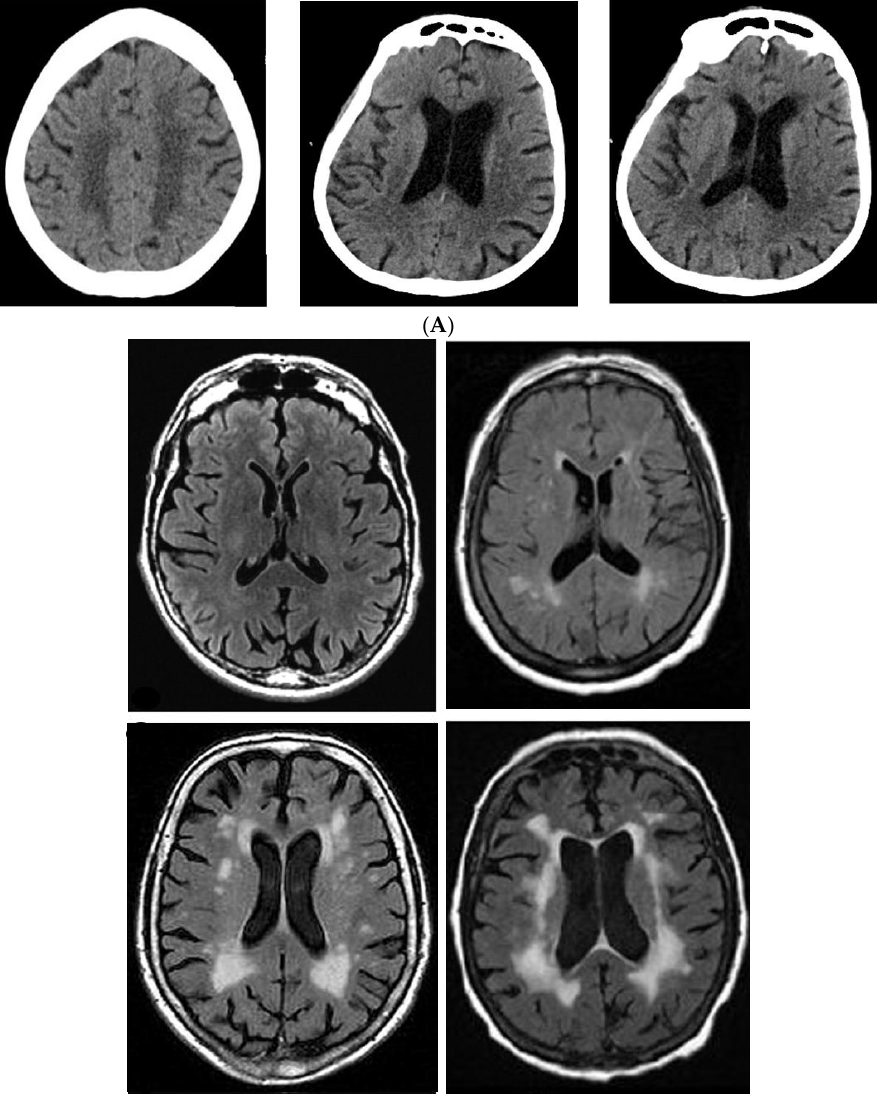
Figure 1. ( A ) Non-contrast brain computed tomography with leukoaraiosis. ( B ) FLAIR MRI sequences with increasing severity of deep and periventricular white matter hyperintensities.